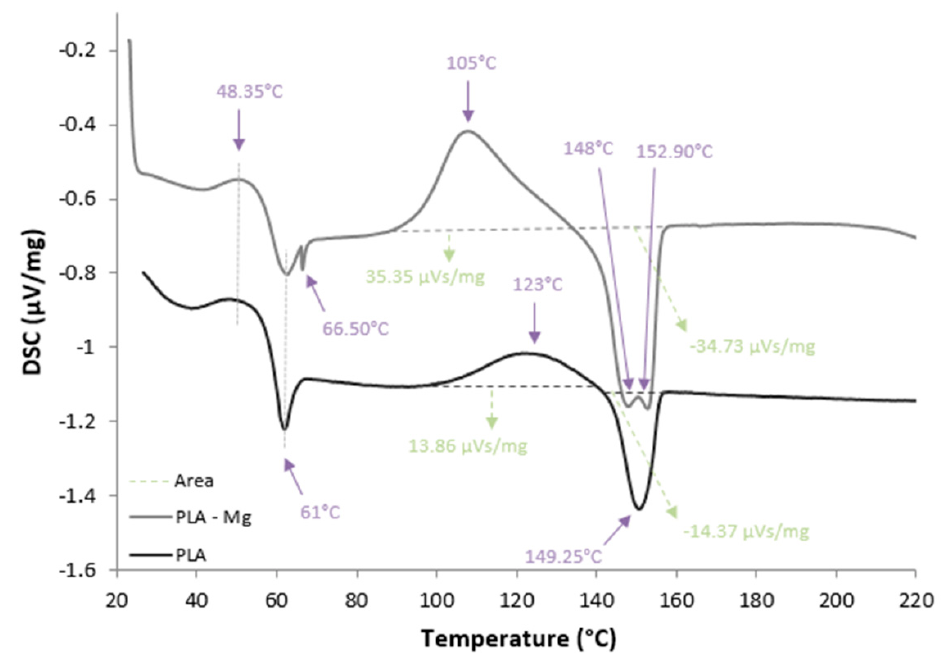
Figure 6. DSC curves of the experimental samples: PLA sample, PLA-Mg (Composition 1).